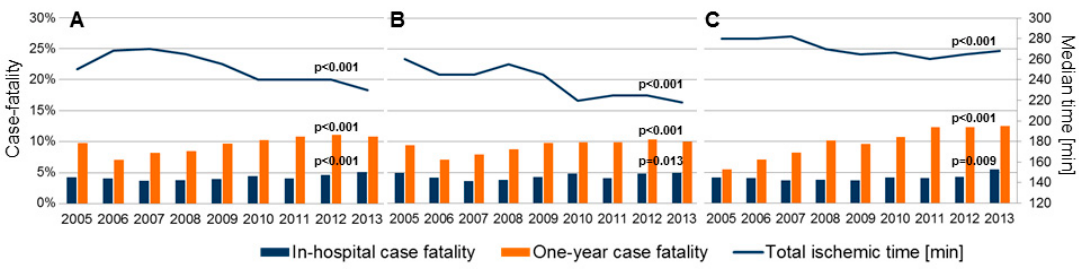
Figure 3. Temporal trends in the median annual total ischemic time matched with rates of in-hospital and one-year mortality 2006–2013 in all patients ( A ), patients admitted directly ( B ), and transferred patients ( C ); p value for trend.